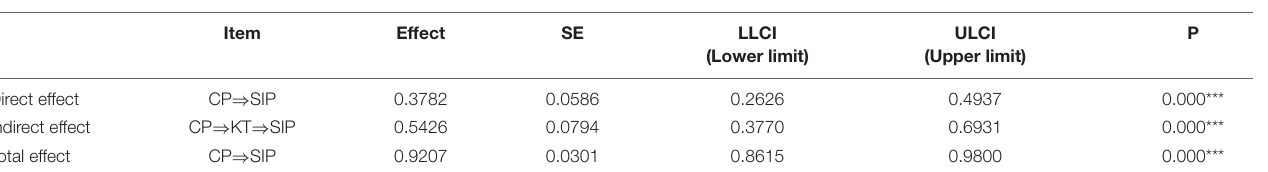
TABLE 6 | Bootstrap analysis of mediation